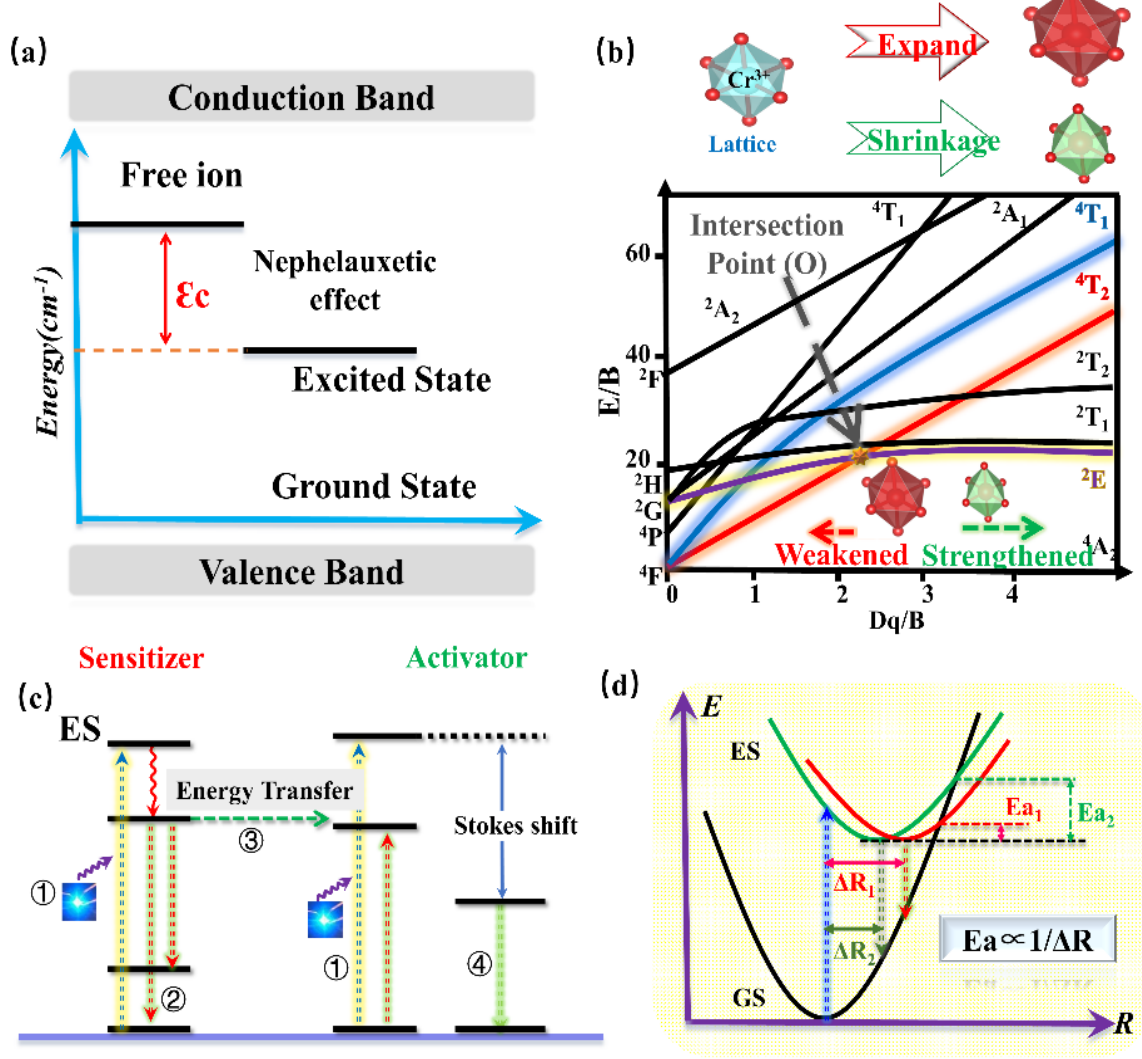
Figure 17. ( a ) Energy level diagram for Cr 3+ . ε c is a barycenter shift. ( b ) Crystal field strength of Cr 3+ according to different lattice sizes. ( c ) Energy transfer model. ( d ) The configurational coordinate models.